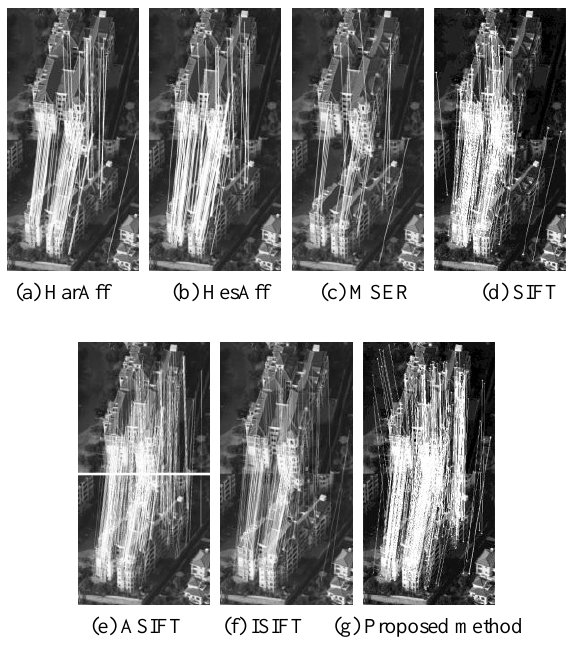
Figure 11. Matching results based on Dataset